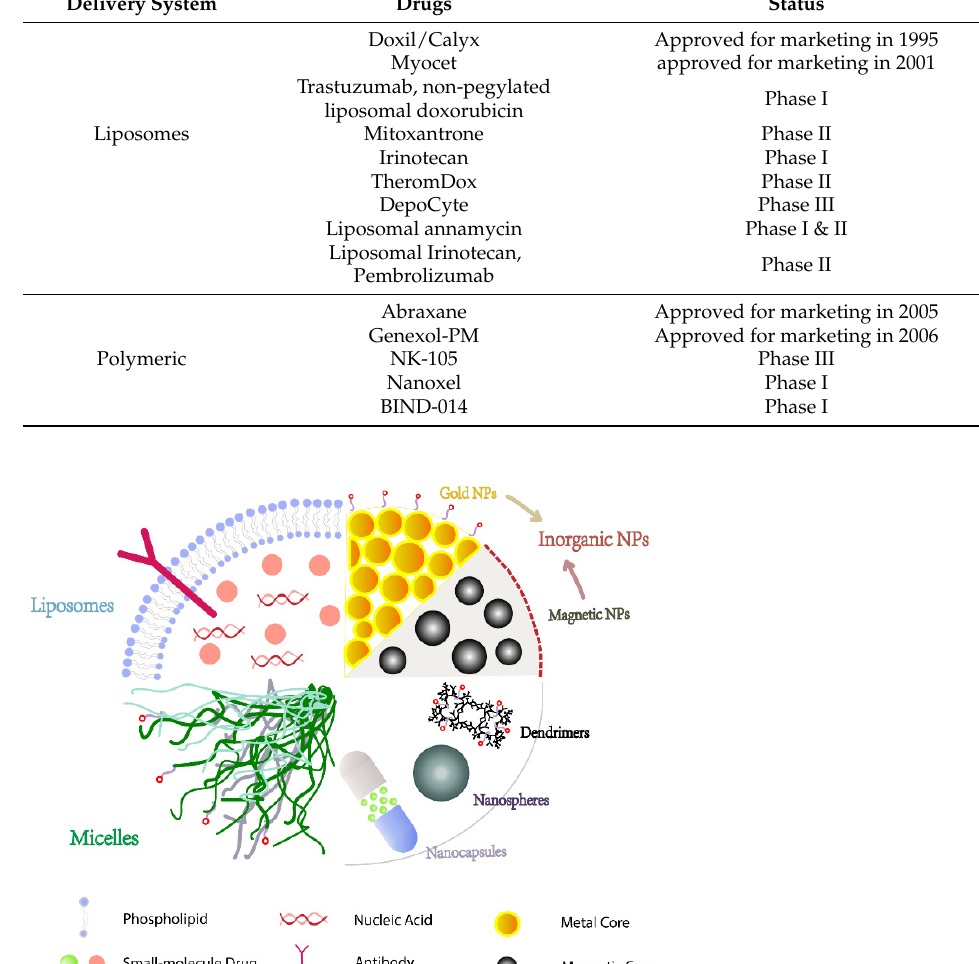
Table 1. Nanoparticles approved or currently in clinical trials for breast cancer.